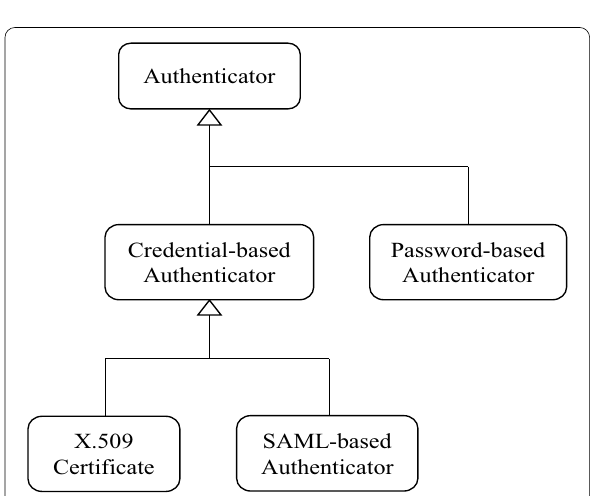
Fig. 4 Pattern diagram for an authentication